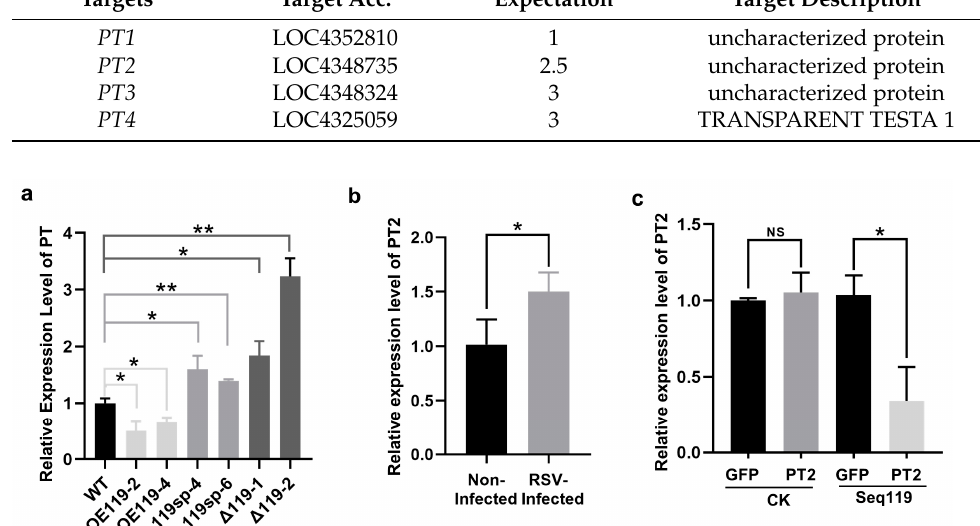
Table 1. Predicted targets of Seq119. Targets Target Acc. Expectation